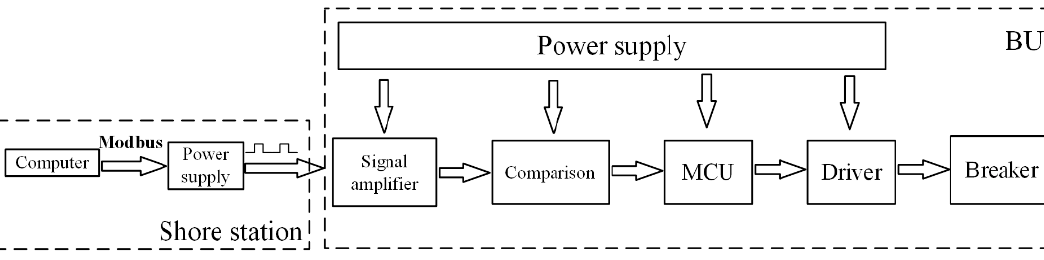
Figure 13. Control method of BU.